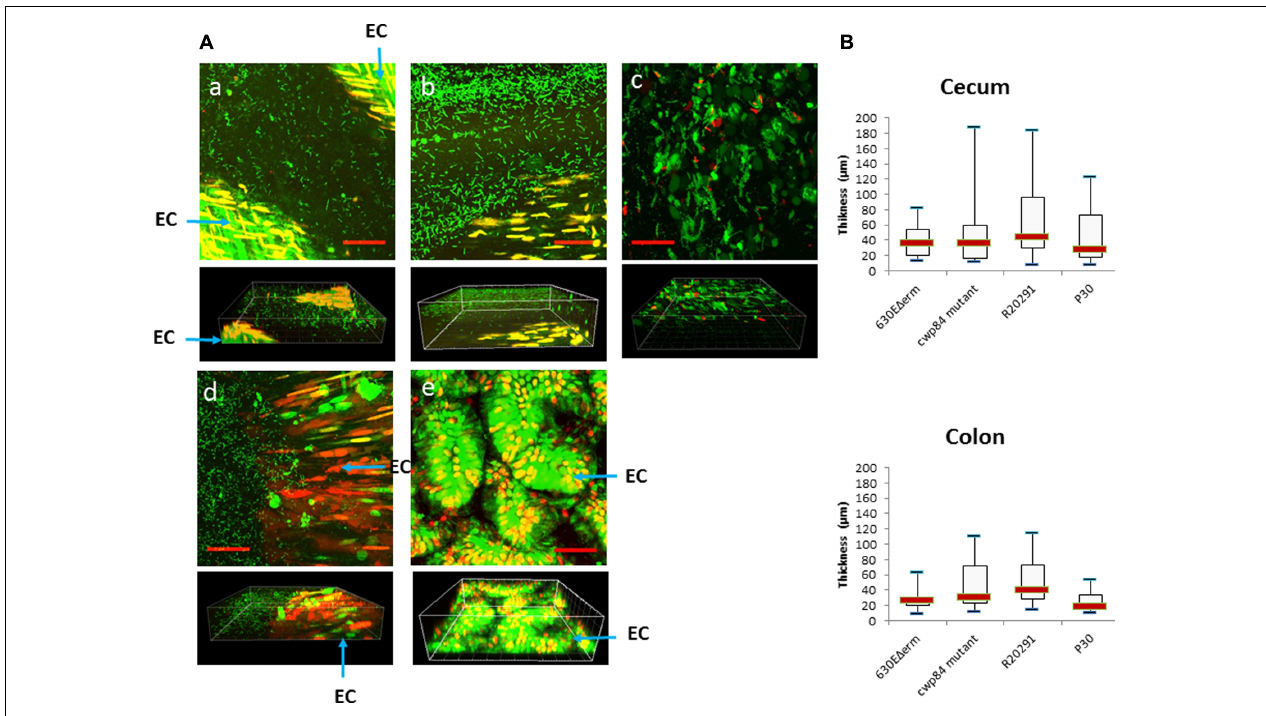
FIGURE 2 | Heterogeneous distribution of bacteria over the tissue in a mono-associated mouse model. Images are representative of at least five fields. (A) Confocal laser-scanning microscopy (CLSM) images ( Z -stacks (above) and 3-D projection (below)] of tissue-associated bacteria obtained from cecum for the 630 (cid:49) erm (a), the cwp84 mutant (b), the R20291 (c), the P30 (d) strains and the germ-free mouse (e). Live cells [bacterial (rod) or epithelial] are labeled in green, dead cells are labeled in red. EC, epithelial cells. Scale bars (red): 50 µ m. (B) Thickness of bacterial 3-D structure in cecum and colon. The thickness of the bacterial 3-D structure is defined by the height on which bacteria are distributed. The thickness was determined directly from confocal Z -stack images. At least three mice were used for CLSM analyses for each strain, and at least eight fields per sample were observed. Data are presented as boxplots with median and minimum-maximum whiskers. No significant difference was observed between strains (Mann–Whitney test).